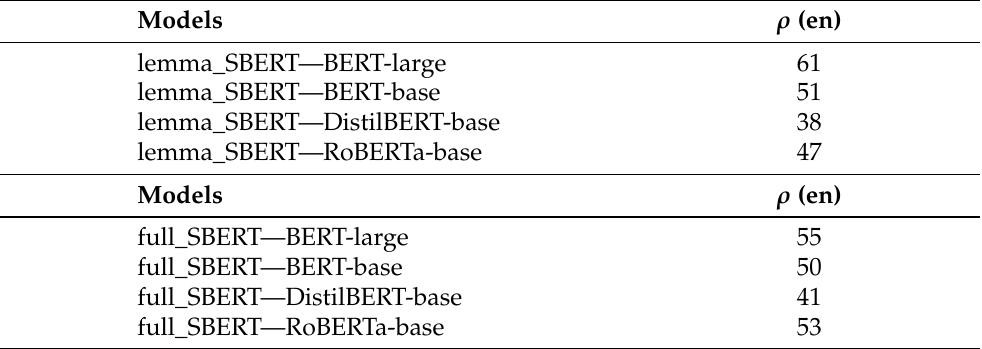
Table 3. Spearman correlation between different models of SBERT and human judgments for English. Top: scores obtained using lemma triples (original dataset). Bottom: scores with full sentences derived from the